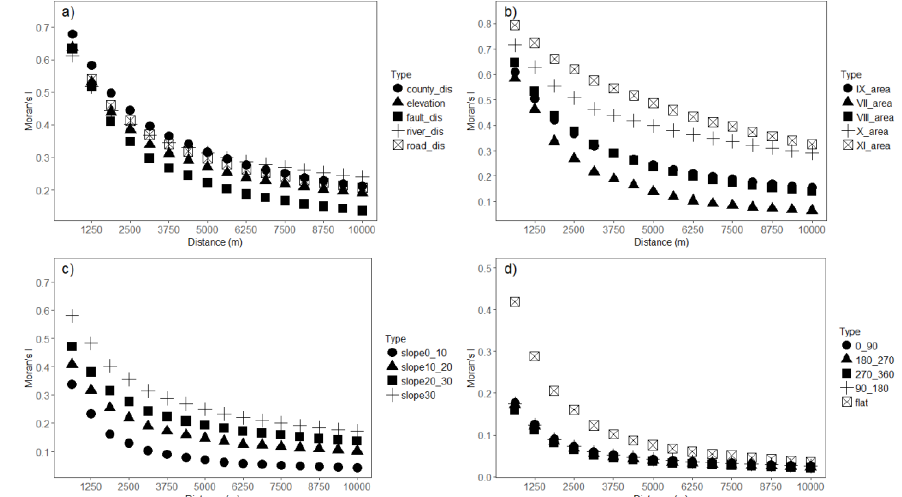
Figure 4. The correlograms of the Moran’s I in 19 potential driving factors at the aggregation level 1 × 1. ( a ): Correlograms with Moran’s I in the distances of factors and elevation; ( b ): Correlograms with Moran’s I in seismic intensity zones; ( c ): Correlograms with Moran’s I in slope classes; ( d ): Correlograms with Moran’s I in slope aspects. The points in black are significant ( P > 0.001). The driving factor